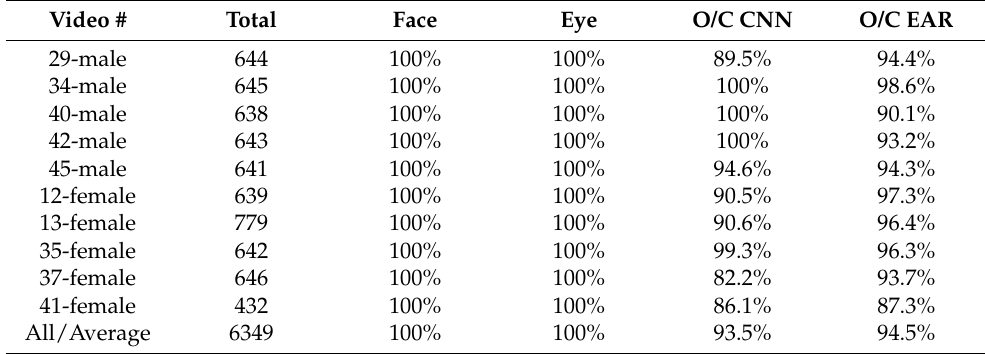
Table 1. Detection accuracy. Total: total number of images. Face: face detection accuracy. Eye: eye detection accuracy. O/C CNN: detection accuracy of eye open/close using CNN. O/C EAR: detection accuracy of eye open/close using EAR.